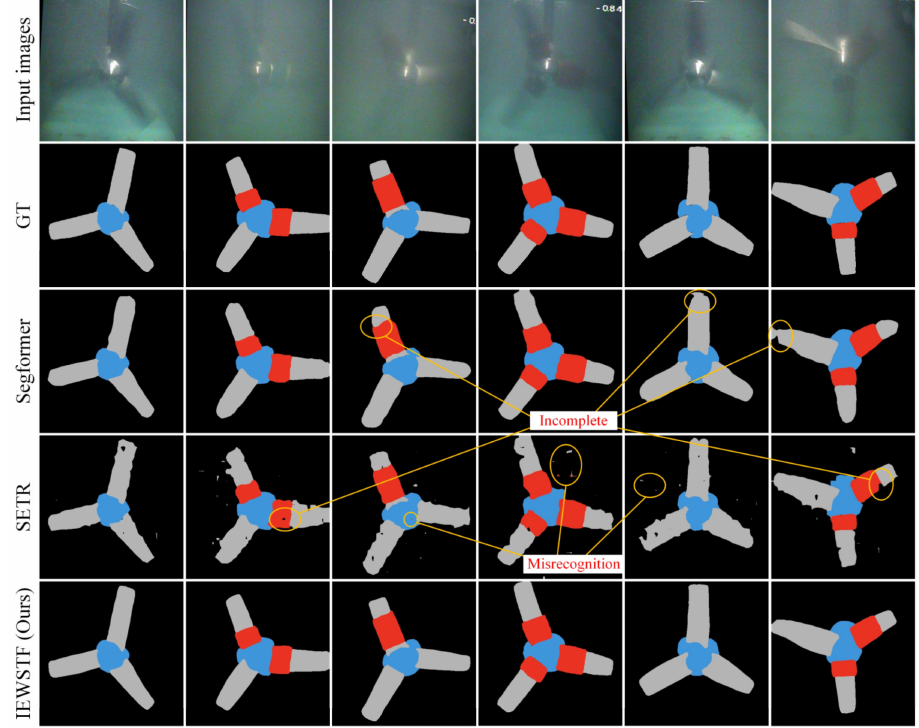
Figure 4. Qualitative comparison of segmentation maps of different